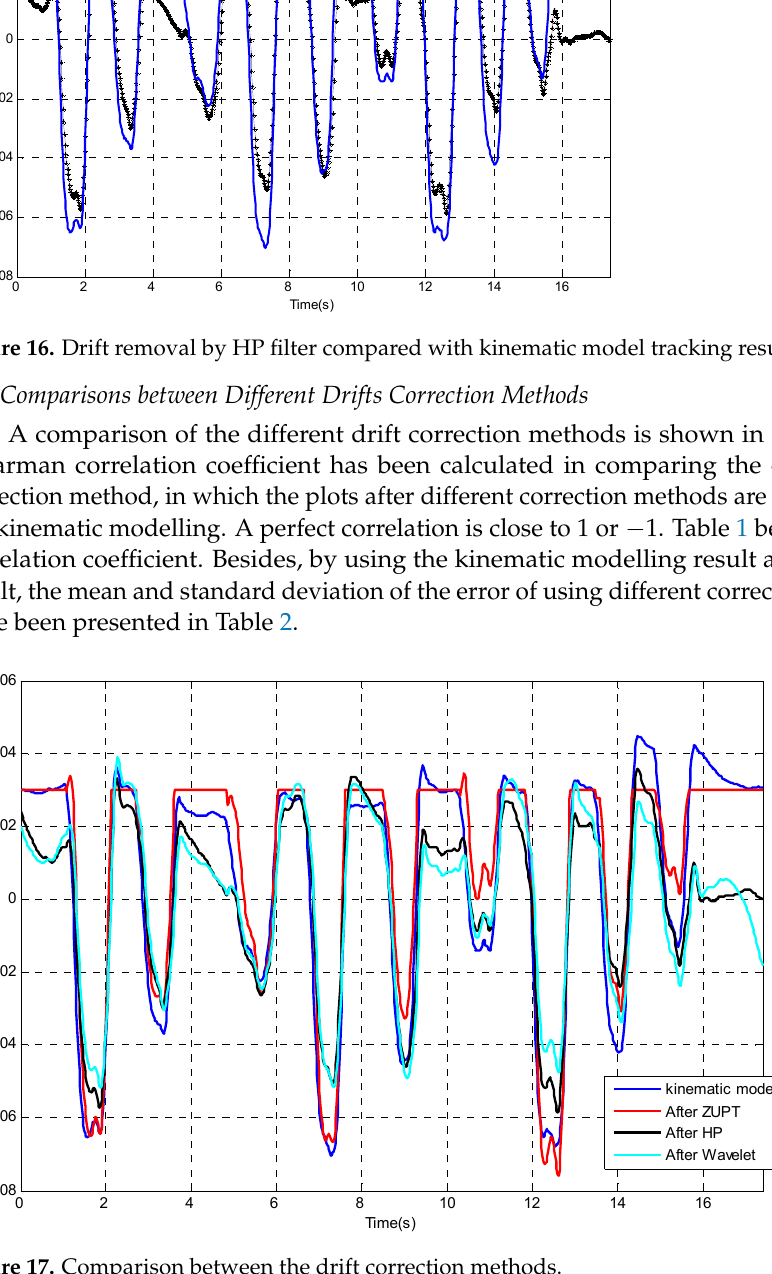
Figure 15. Drift correction result after applying the 0.03 Hz HP filter. ( a ) Experiment Test 1. ( b )